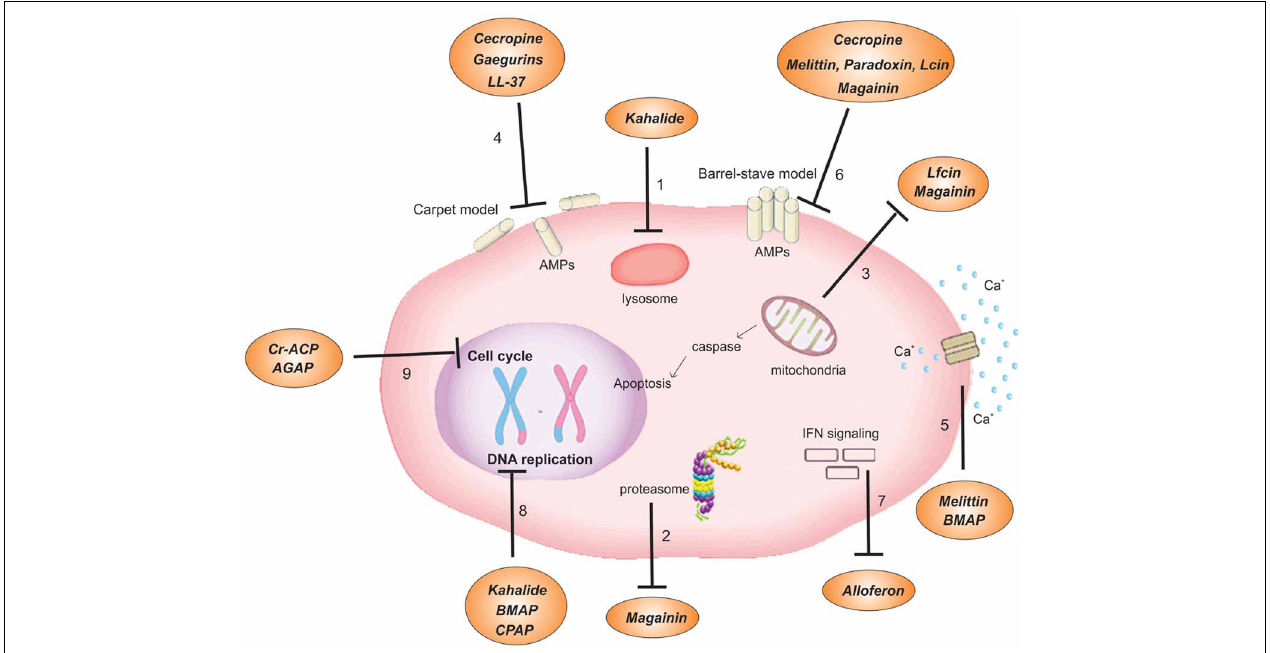
FIGURE 1 | Mechanisms of action of cationic antitumor peptides. (1) Modification of the lysosome membrane leading to an acidification of the intracellular environment and cell death. (2) Amplification of the proteasome activity. (3) Induction of mitochondrial pathway of apoptosis by either the cytochrome c release into the cytoplasm or activation of the caspase cascade. (4) Pore formation by the carpet model. (5)